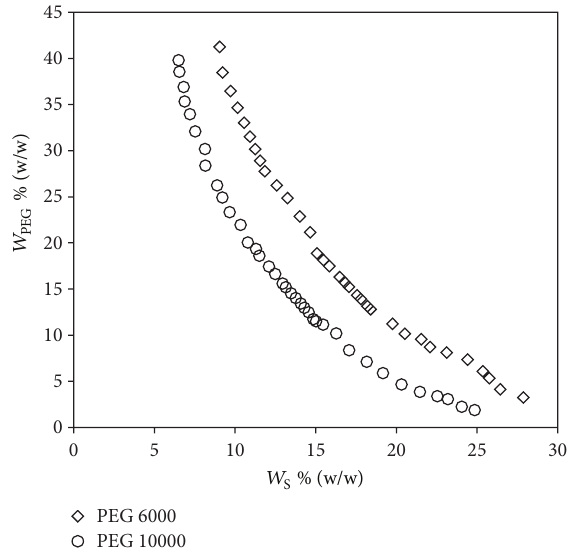
Figure 5: Effect of molecular weight of PEG on the binodal curve ) + sodium succinate ( 𝑊 for the PEG ( 𝑊 PEG 298.15